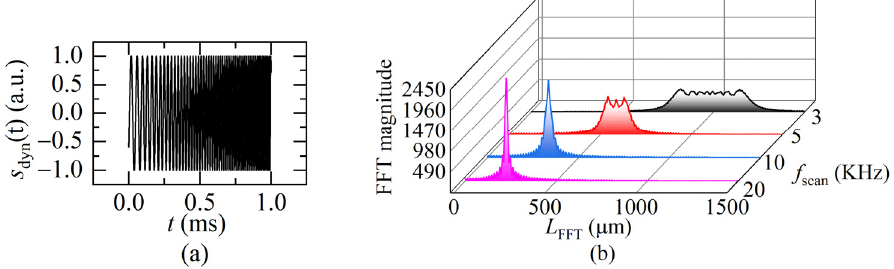
Figure 6. ( a ) The dynamic FSI signal ( L (0) = 250 μ m, f sweep = 1 KHz, v = 0.01 m/s, a = 50 m/s 2 ) in one sweeping cycle; ( b ) the FFT transformation of the different sweeping rate. ( L (0) = 250 μ m, a = 200 m/s 2 , v = 0.1m/s).